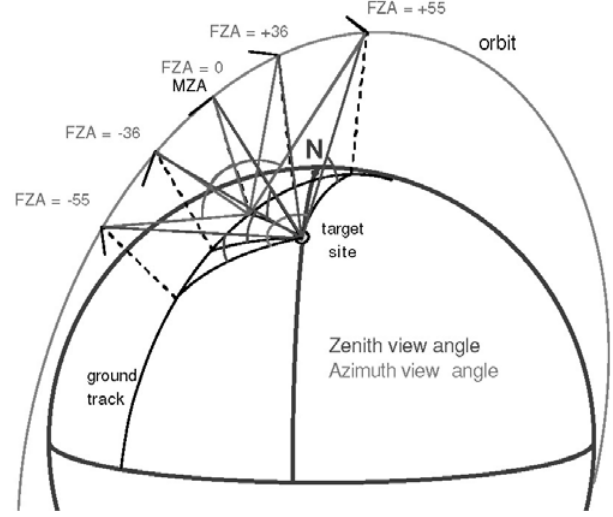
Figure 1. Schematic view of PROBA/CHRIS acquisition